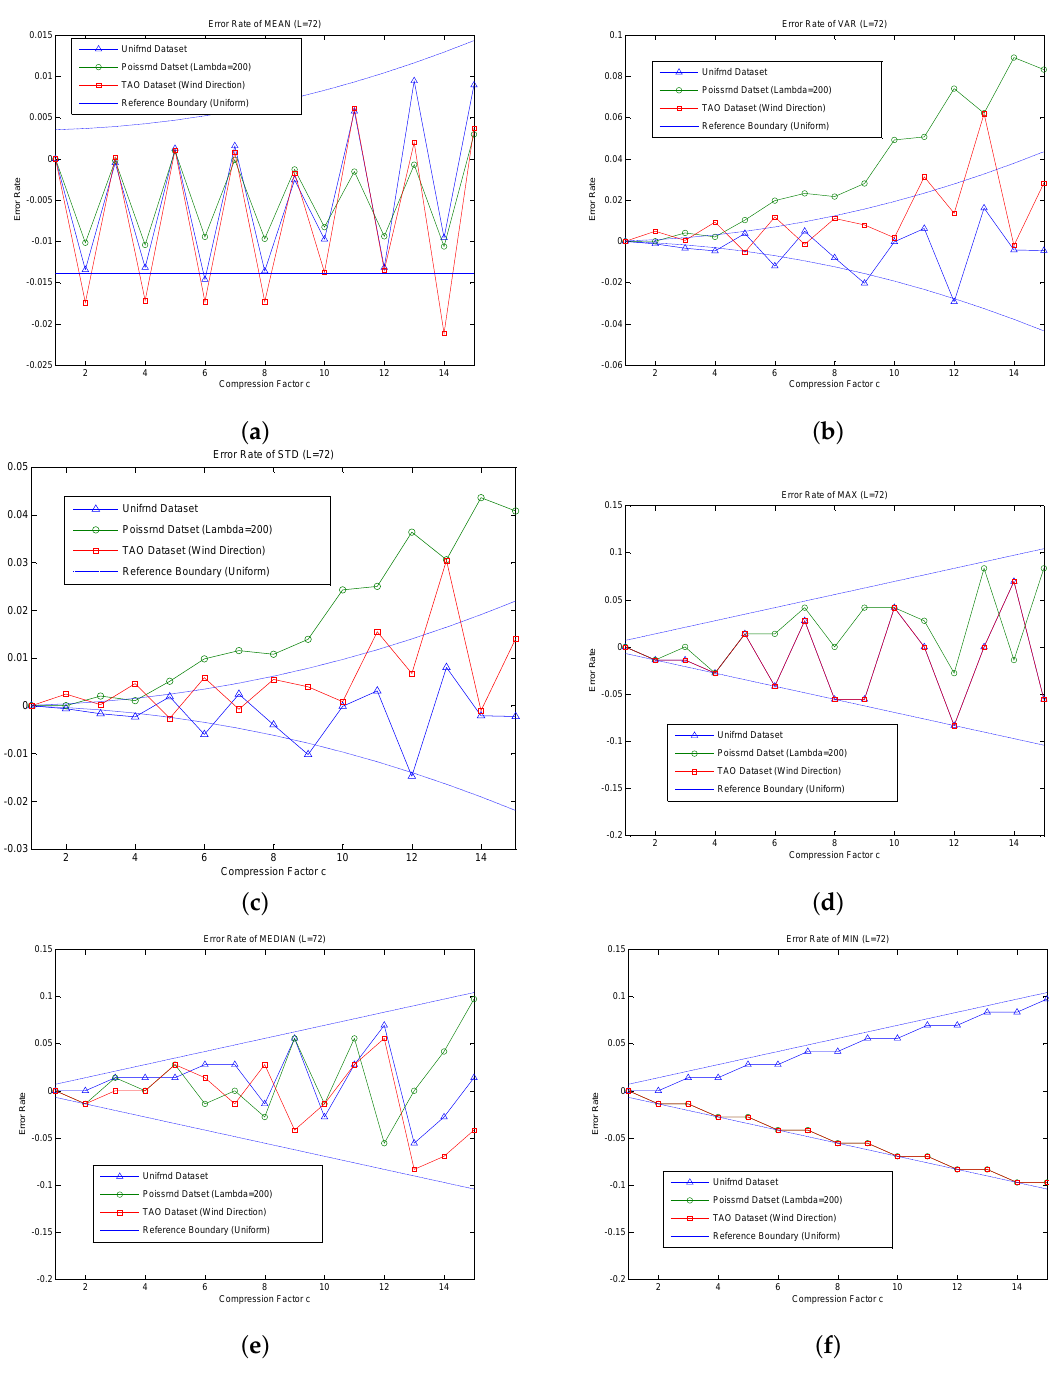
Figure 5. Accuracy evaluation of the MFSDA variant. ( a ) Error rate of MEAN; ( b ) error rate of VAR; ( c ) error rate of STD; ( d ) error rate of MAX; ( e ) error rate of MEDIAN; ( f ) error rate of